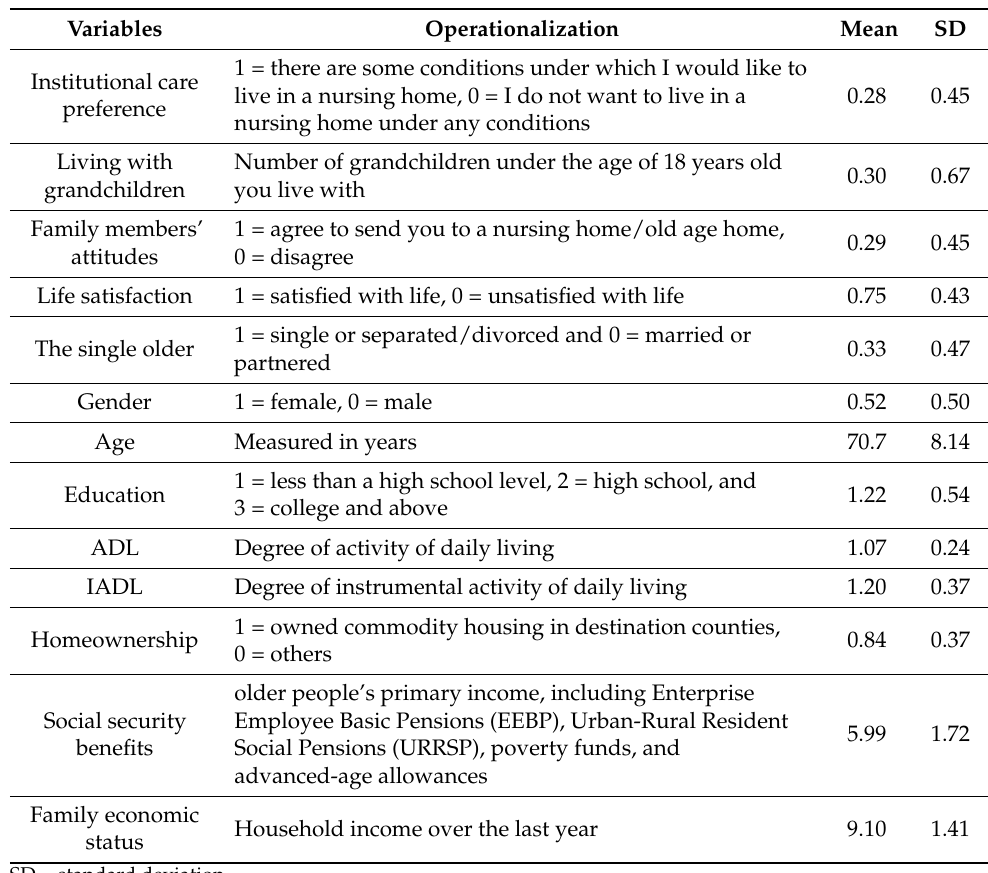
Table 1. Definition of